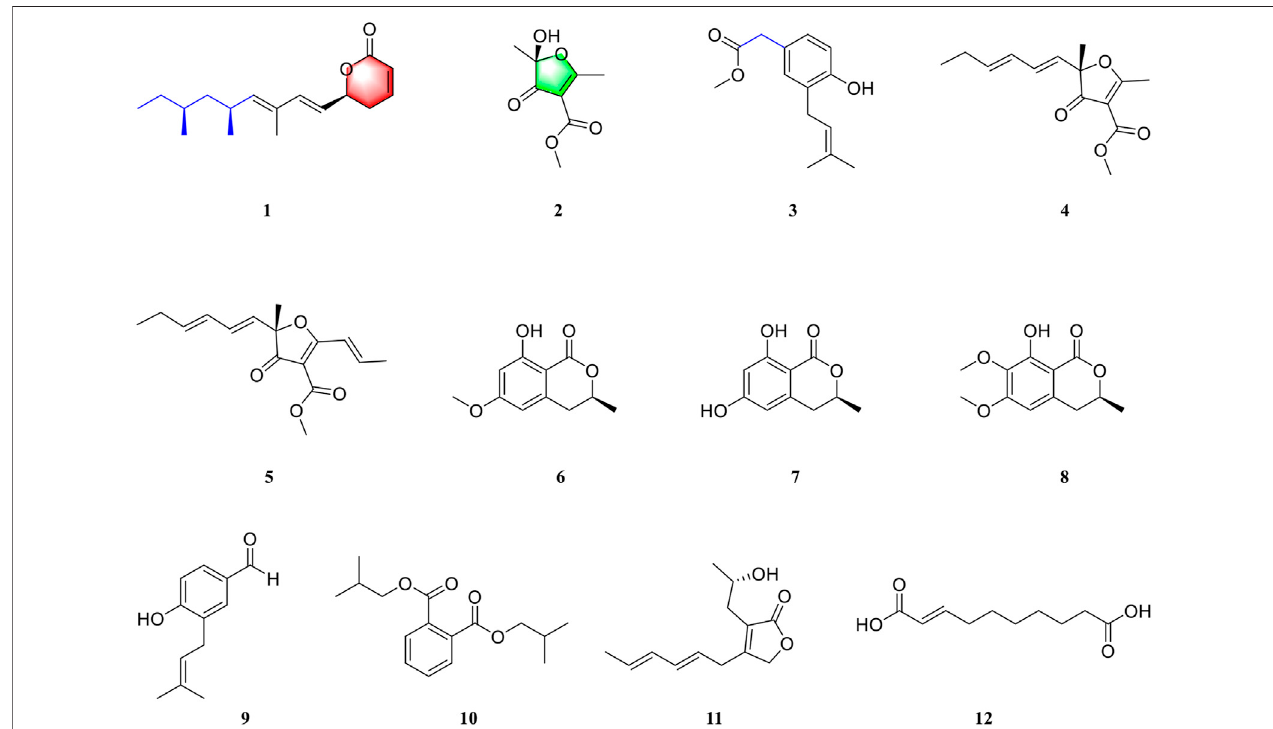
FIGURE 1 | Structures of compounds 1 – 12